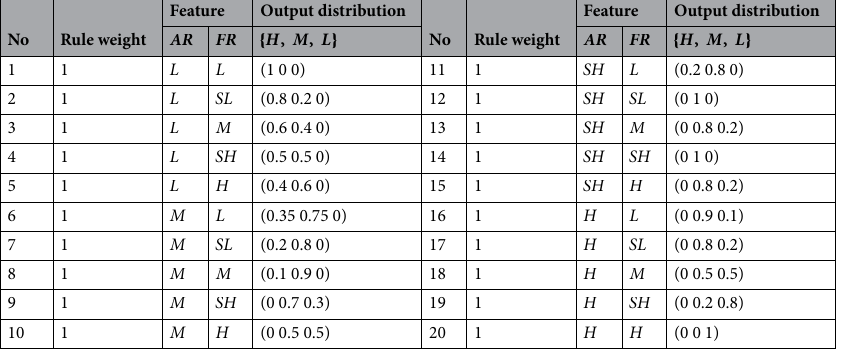
Table 4. Initial health prediction model for the WSN.